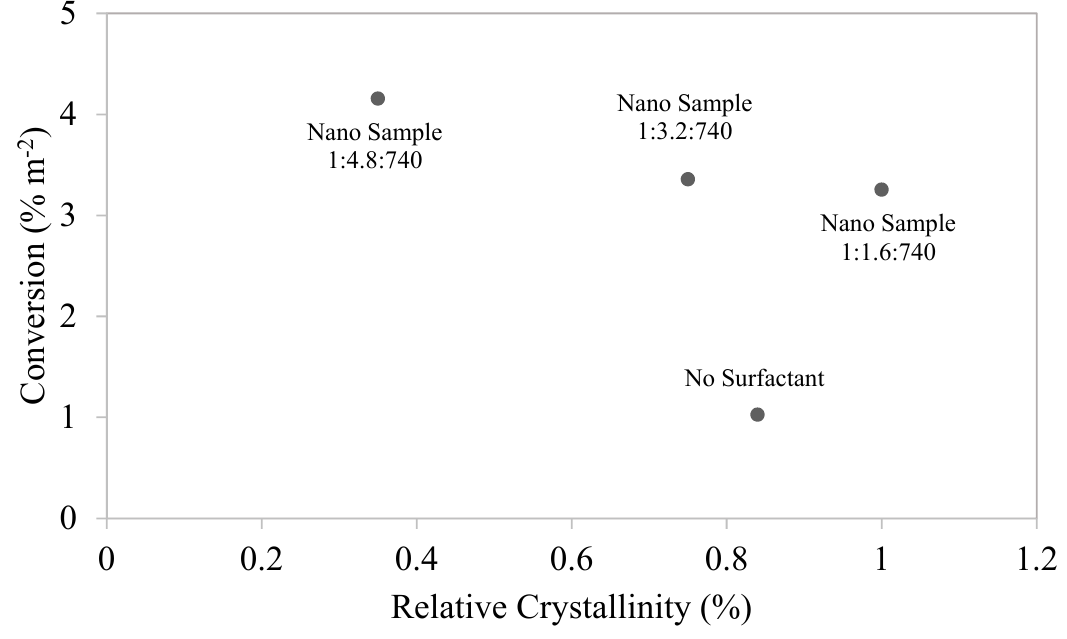
Figure 9. Relative crystallinity (%) vs. conversion (% m − 2 ).